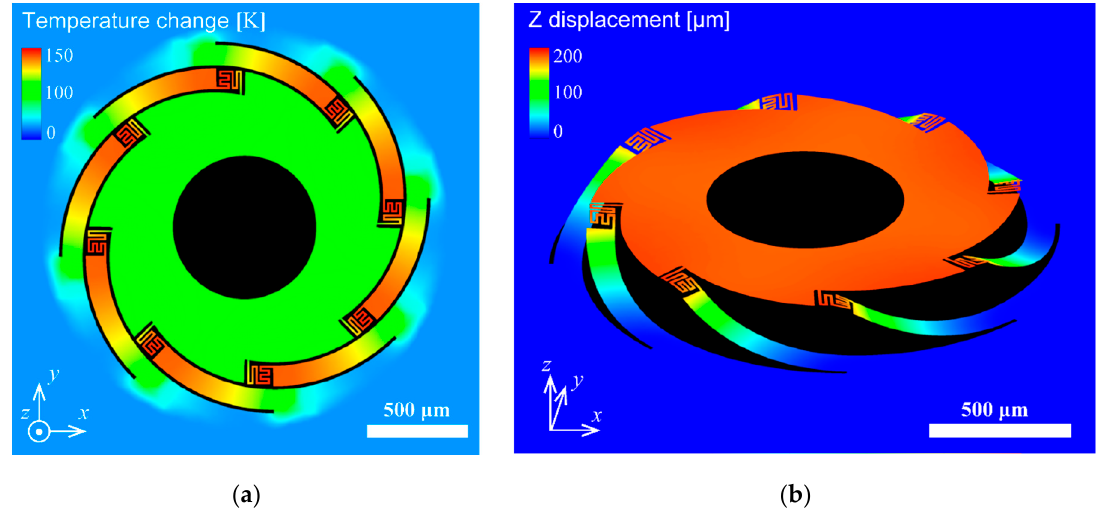
Figure 3. Finite element modeling (FEM) simulation of the microelectromechanical system (MEMS) scanner: ( a ) temperature distribution and ( b ) out-of-plane actuation with approximately 0.2 mm vertical displacement.